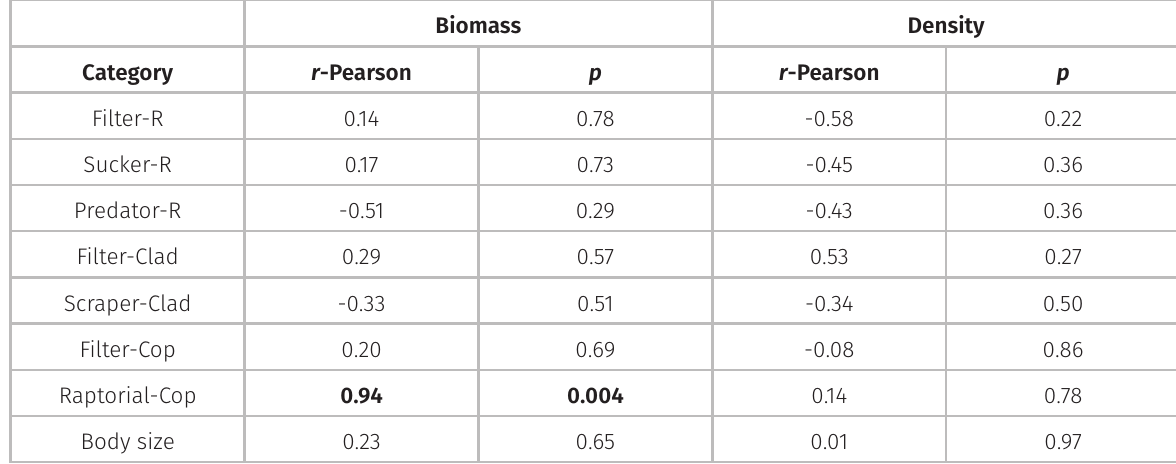
Table III. Result of Pearson’s correlations of feeding type categories (abundance) and body size of zooplankton (CWM) with biomass and periphytic algae